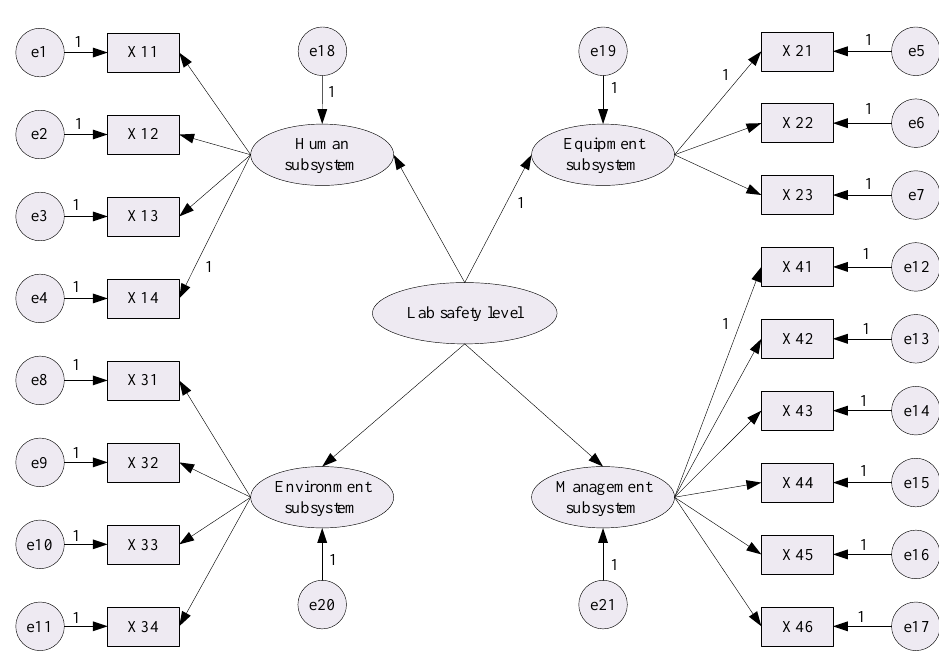
Figure 2. Initial SEM for laboratory safety level.